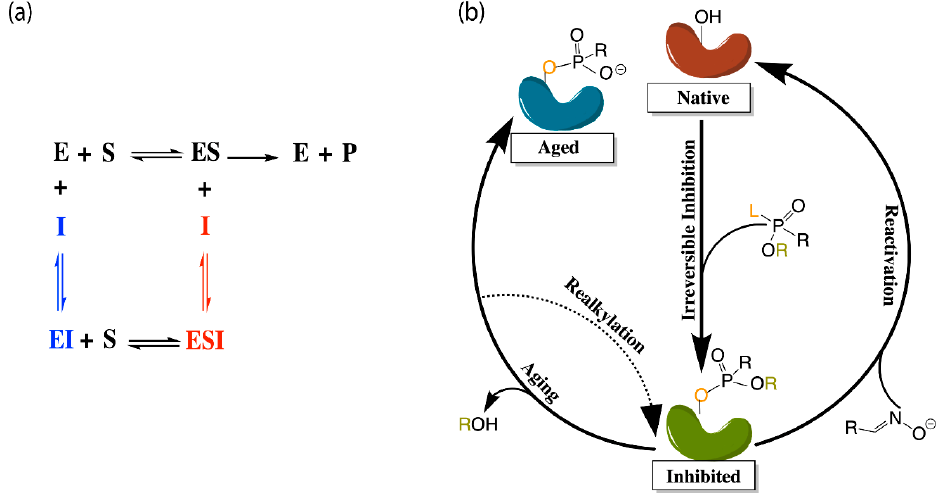
Figure 2. ( a ) Depiction of the enzyme catalytic mechanism (black) and reversible inhibition mecha- nisms including competitive inhibition (blue), uncompetitive inhibition (red), and noncompetitive inhibition (both blue and red). ( b ) Representation of irreversible (covalent) inhibition by organo- phosphorus ligands and the reactivation mechanisms to revert the aged enzyme (blue) back to the inhibited complex (green). L and R represent the first and second leaving groups of the organophosphate, respectively, following the paths of inhibition and reactivation.